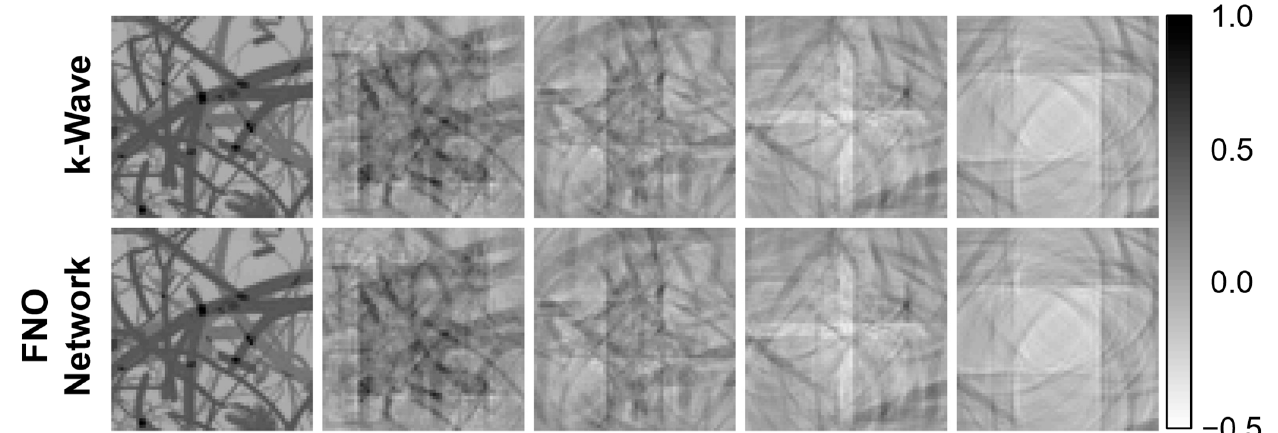
Figure 3. Visual comparison of the ground truth ( Top Row) using k-Wave and the FNO network ( Bottom Row) simulated photoacoustic wave propagation for an example vasculature image in a homogeneous medium at t = [1, 20, 40, 60, 80] time steps. The RMSE over all time steps was 3.8 × 10 − 3 for this example.